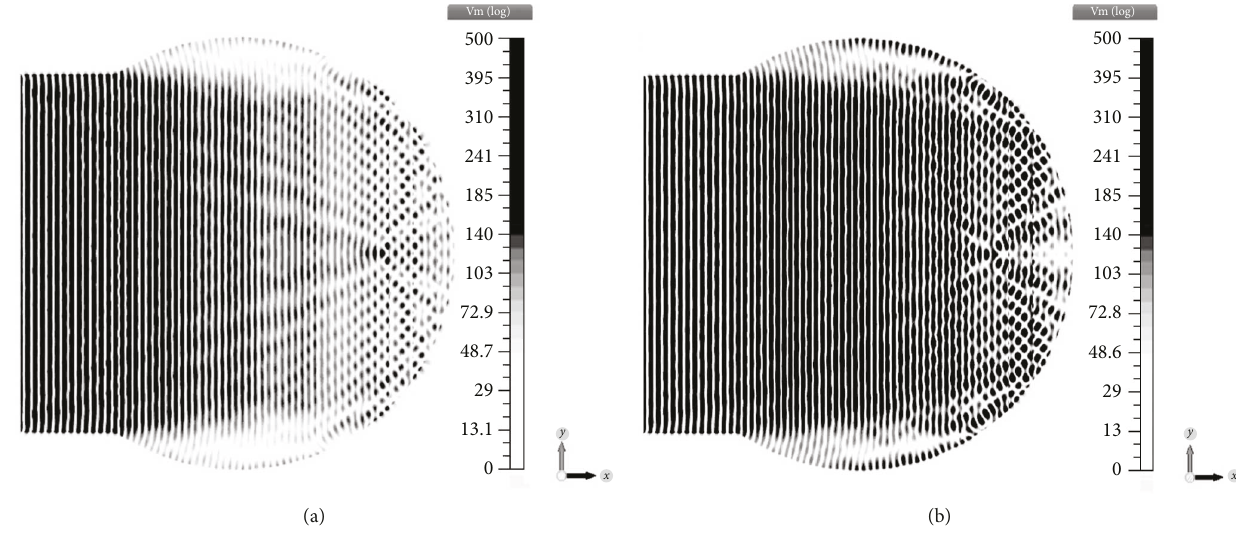
Figure 8: Comparison of electric fi eld intensity in PPW at 12.5GHz before and after double nonlinear design of h and h wg . (a) Constant h wg , constant h , (b) nonlinear h wg , and nonlinear h